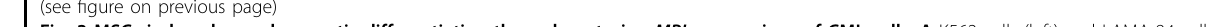
(OE-K562 cells) and LAMA-84 cells (OE-LAMA cells) (Fig. S6E, F). The expressions of differentiation markers in OE-K562/OE-LAMA cells were determined by RT-qPCR and fl ow cytometry in the presence or absence of MPL aganisit, eltrombopag. Figures 3H, I and S6G showed